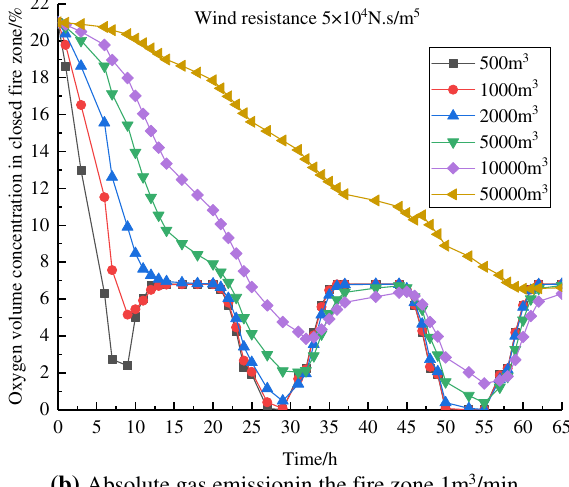
(b) Absolute gas emission in the fire zone 1m 3 /min Fig. 10 The changes of different gas emission, different fire zone volume, and small wind resistance, the gas concentration in the fire zone with time after the completion of closing at 24:00